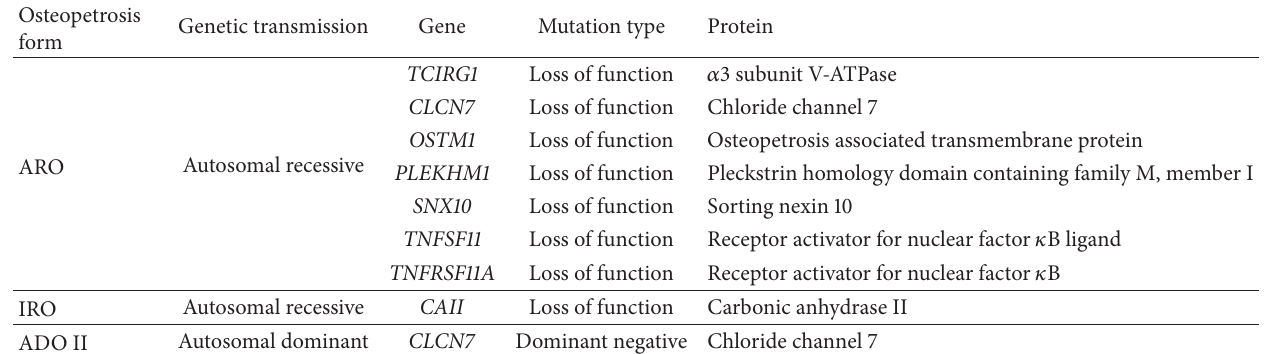
Table 1: Genes mutated in osteopetrotic